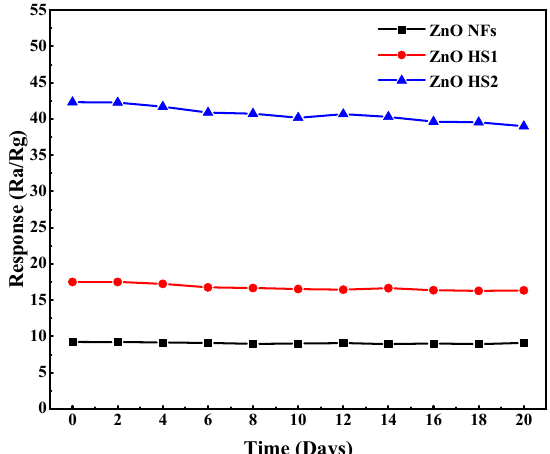
Figure 8. The long-term stability of ZnO NFs, ZnO HS1 and ZnO HS2 gas sensors toward 50 ppm H 2 S at 180 °C.